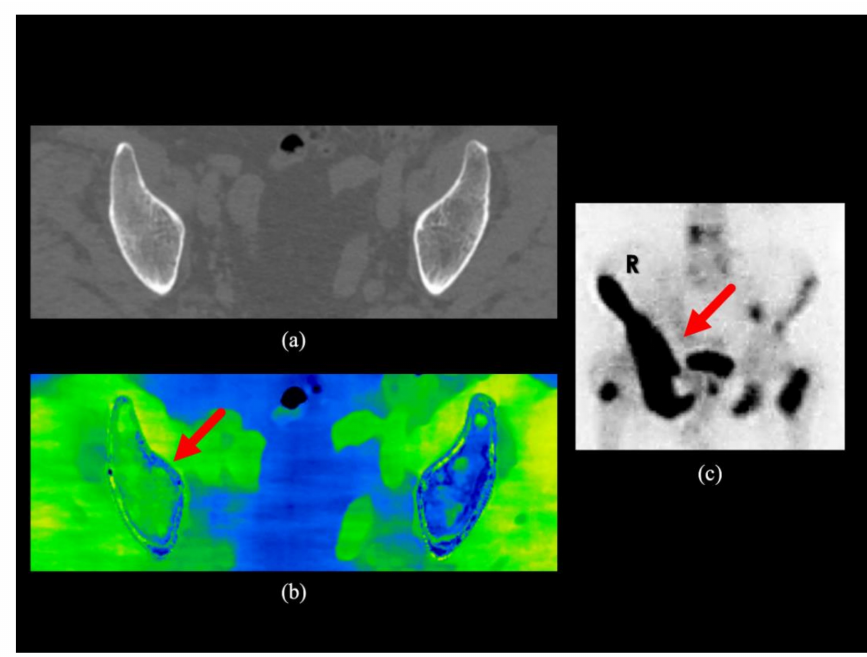
Figure 3. Clinical case 2. A man in his 70s with prostate cancer. ( a ) The transaxial image of the conventional CT of the pelvis does not indicate abnormal concentrations in the iliac bone; ( b ) There is an increase in water density compared to the contralateral side in the transaxial water-HAP image of the pelvis (red arrow); ( c ) The anterior view of the bone scintigraphy shows the right iliac bone metastases (red arrow). HAP; Hydroxyapatite.